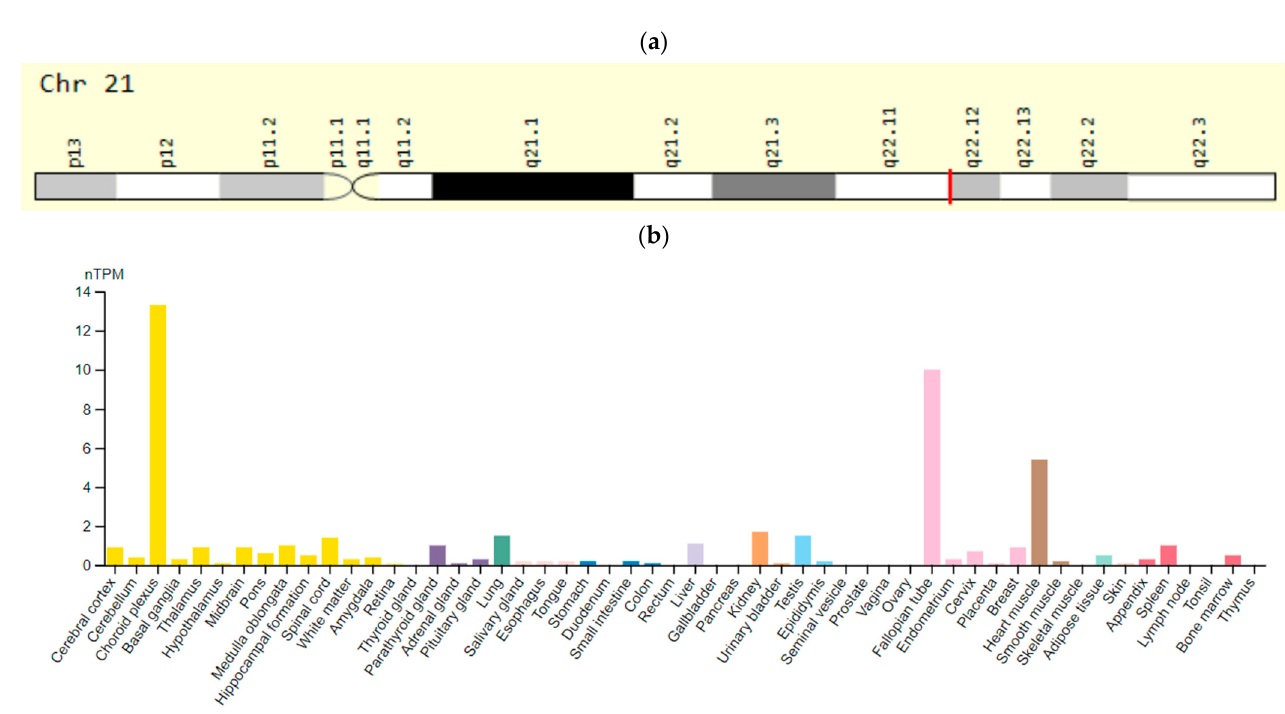
Figure 4. The KCNE1 (MiRP1) gene: ( a )—gene chromosome location; ( b )—protein expression in tissues of the human body [62,63].